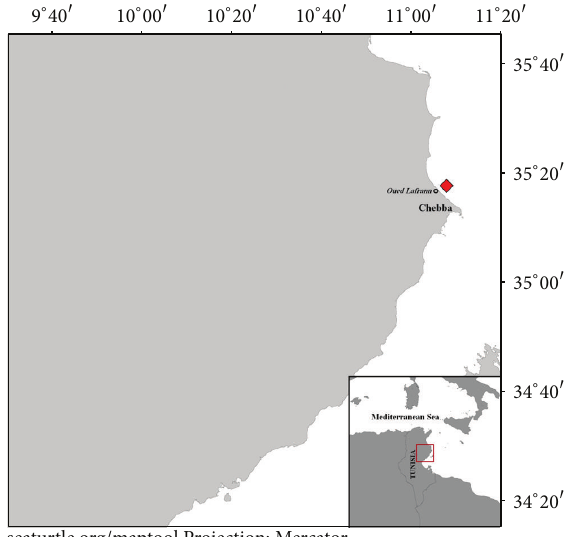
Figure 1: Map of the study area, showing the sampling station.